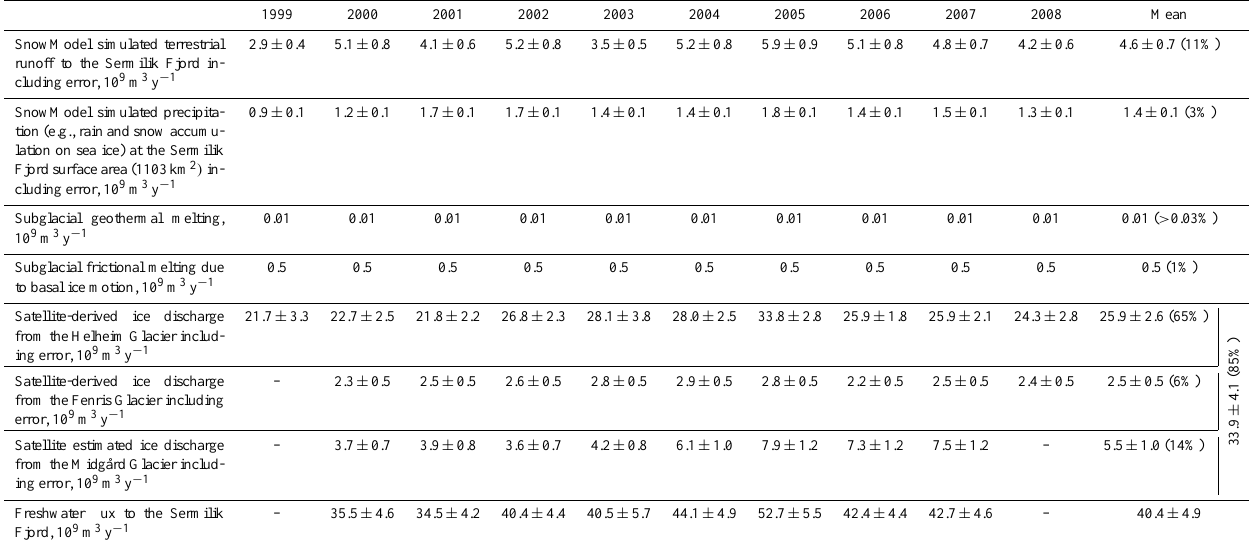
Table 3. Freshwater flux to the Sermilik Fjord based on SnowModel simulated freshwater runoff, precipitation at the Sermilik Fjord surface area, subglacial geothermal melting and subglacial frictional melting due to basal ice motion, and satellite-derived ice discharge from the Helheim Glacier, Fenris Glacier, and Midg˚ard Glacier (the three major outlet glaciers in Sermilik Fjord catchment). Mean freshwater flux to the Sermilik Fjord is calculated based on mean values from each input